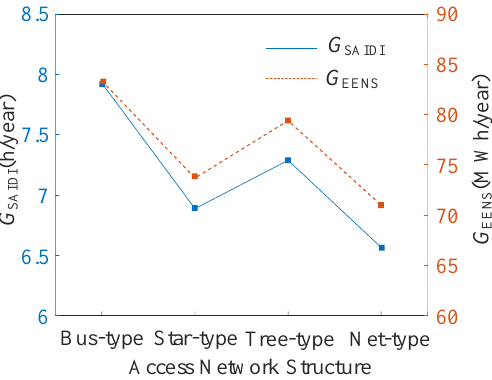
Figure 21. Reliability indices of different access network structures.